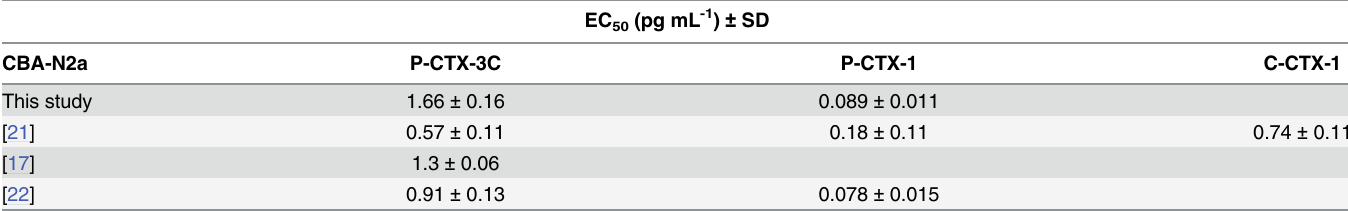
Table 2. CBA-N2a EC 50 Values. Literature and this study ’ s cytotoxicity EC 50 values of the ciguatoxins P-CTX-3C, P-CTX-1, and C-CTX-1 in association with CBA-N2a. Error is represented as ± standard deviations